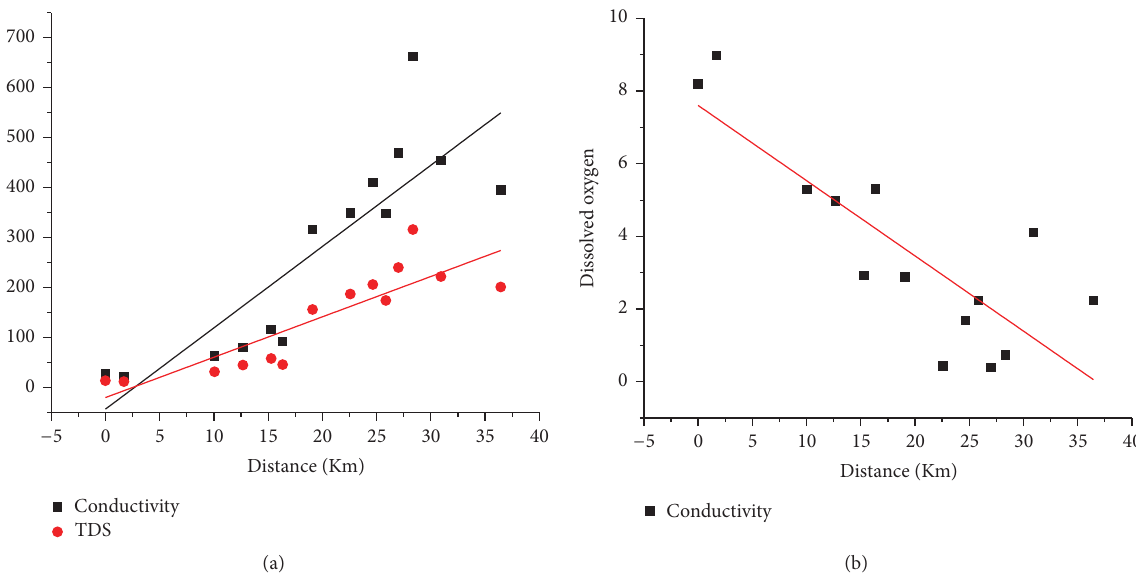
Figure2:Variationof(a)conductivity( 𝜇 S/cm),TDS(mg/L),and(b)dissolvedoxygen(mg/L)alongtheBagmatiRiverwithintheKathmandu Valley (the distance was measured from the